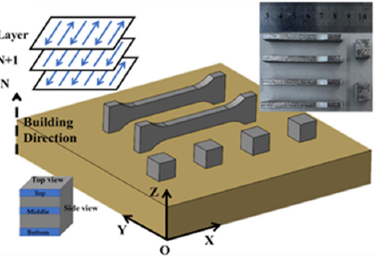
Figure 2. Schematic illustration of the scanning strategies and fabrication of bulks and tensile specimens. Table 2. The process parameters used in this investigation. Laser Power